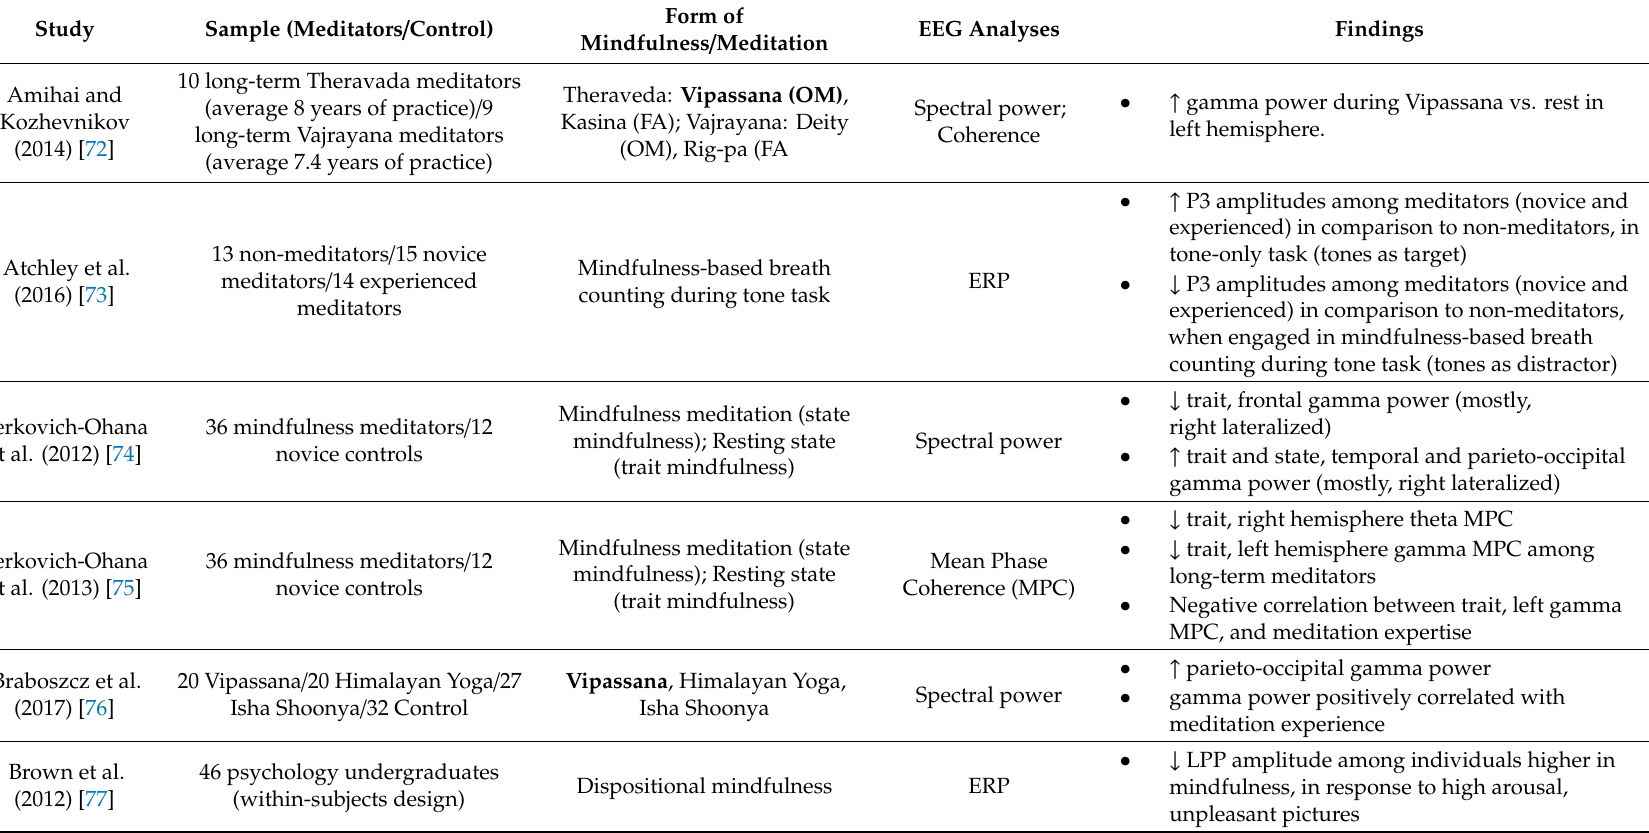
Table 1. Overview of Neurophysiological Studies on Mindfulness using EEG Discussed in the Present Review. Note. State mindfulness = mindfulness induced by meditation; Trait mindfulness = dispositional mindfulness during resting state; ERD = event-related desynchronization; ERS = event-related synchronisation; ERP = event-related potential; OM = open monitoring; FA = focused attention; LPP = late positive potentials; MBCT = mindfulness-based cognitive therapy; MBT = mindfulness-based training; MBSR = mindfulness-based stress reduction. In studies where various meditation styles were examined, the results reported are those relevant to the meditation in bold